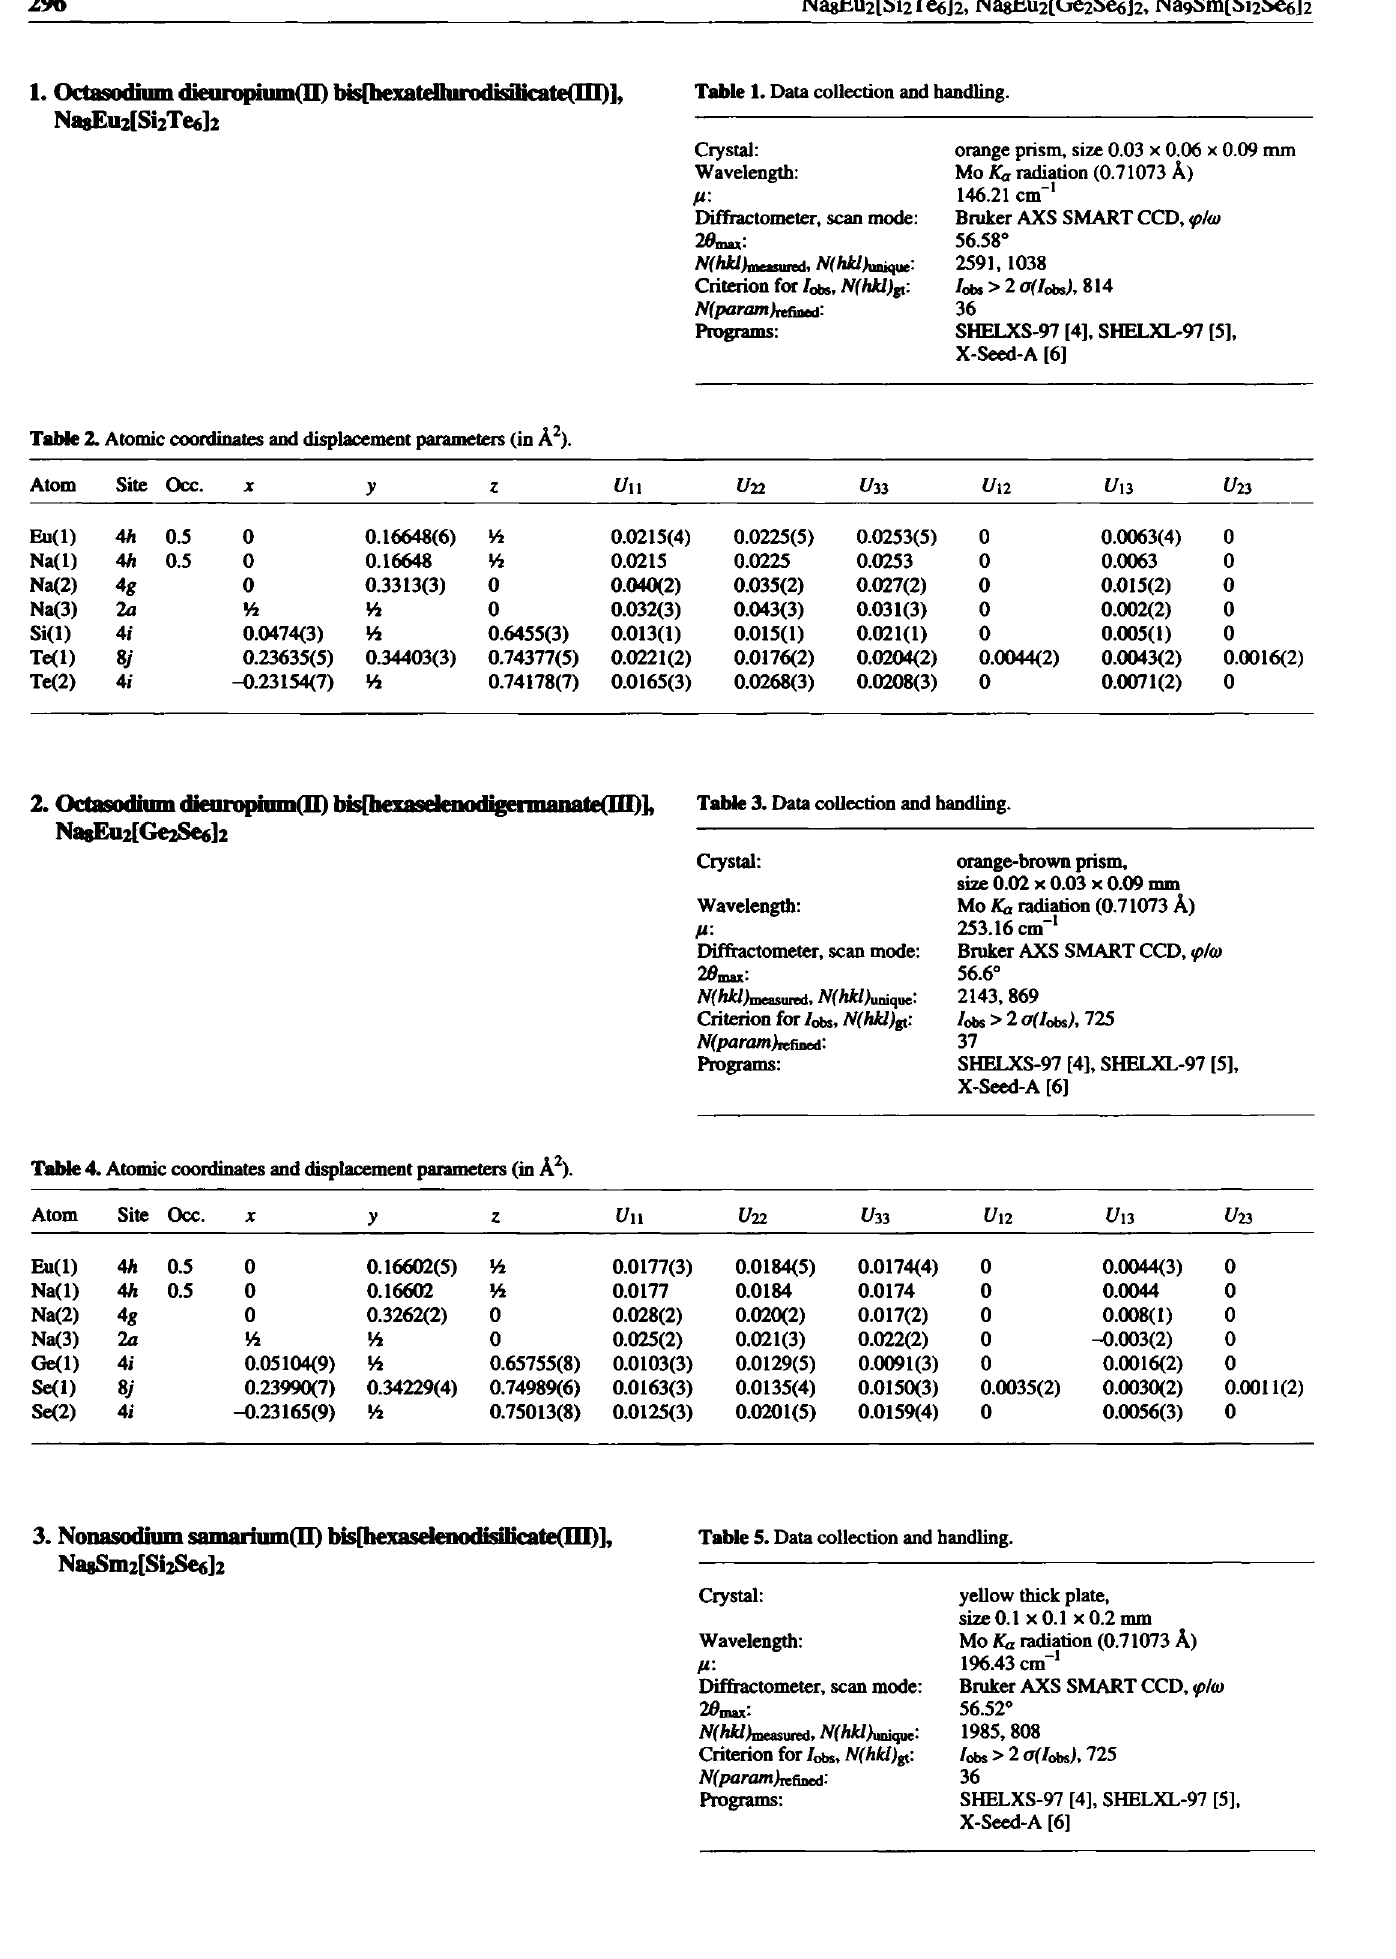
Table 1. Data collection and handling.